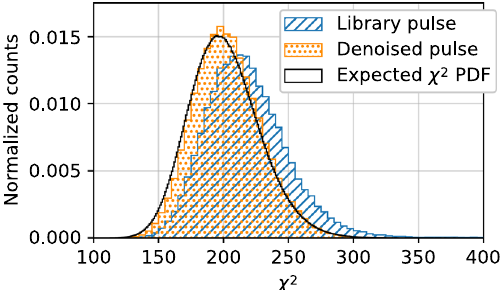
Fig. 11 Energy resolution, defined as the FWHM of the energy distri- bution, as a function of trapezoidal filter shaping time. Calculated on data from the 241 Am source before denoising (dotted line, circle mark- ers)andafterdenoisingwiththeamplitudenormalizedmodel(solidline, triangle markers) and standardized model (solid line, square